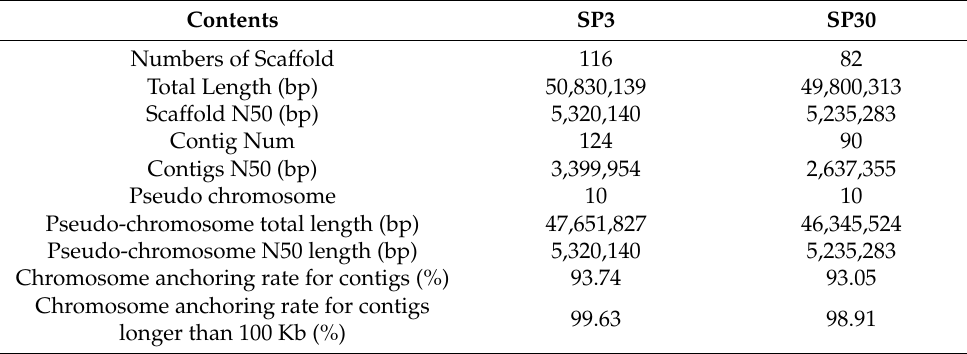
Table 1. Genome assemblies of two monokaryons of Lentinula edodes .